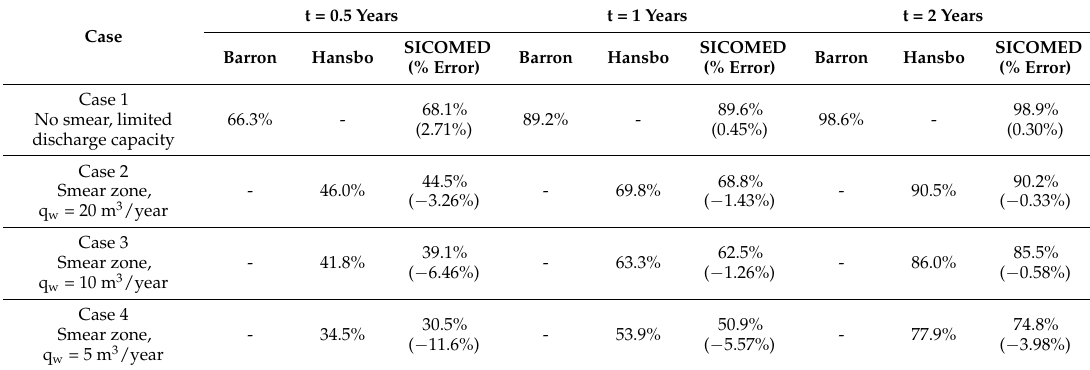
Table 6. Comparison of the average degree of consolidation between SICOMED_2018 and Hansbo et al. [16] and Barron’s [34]